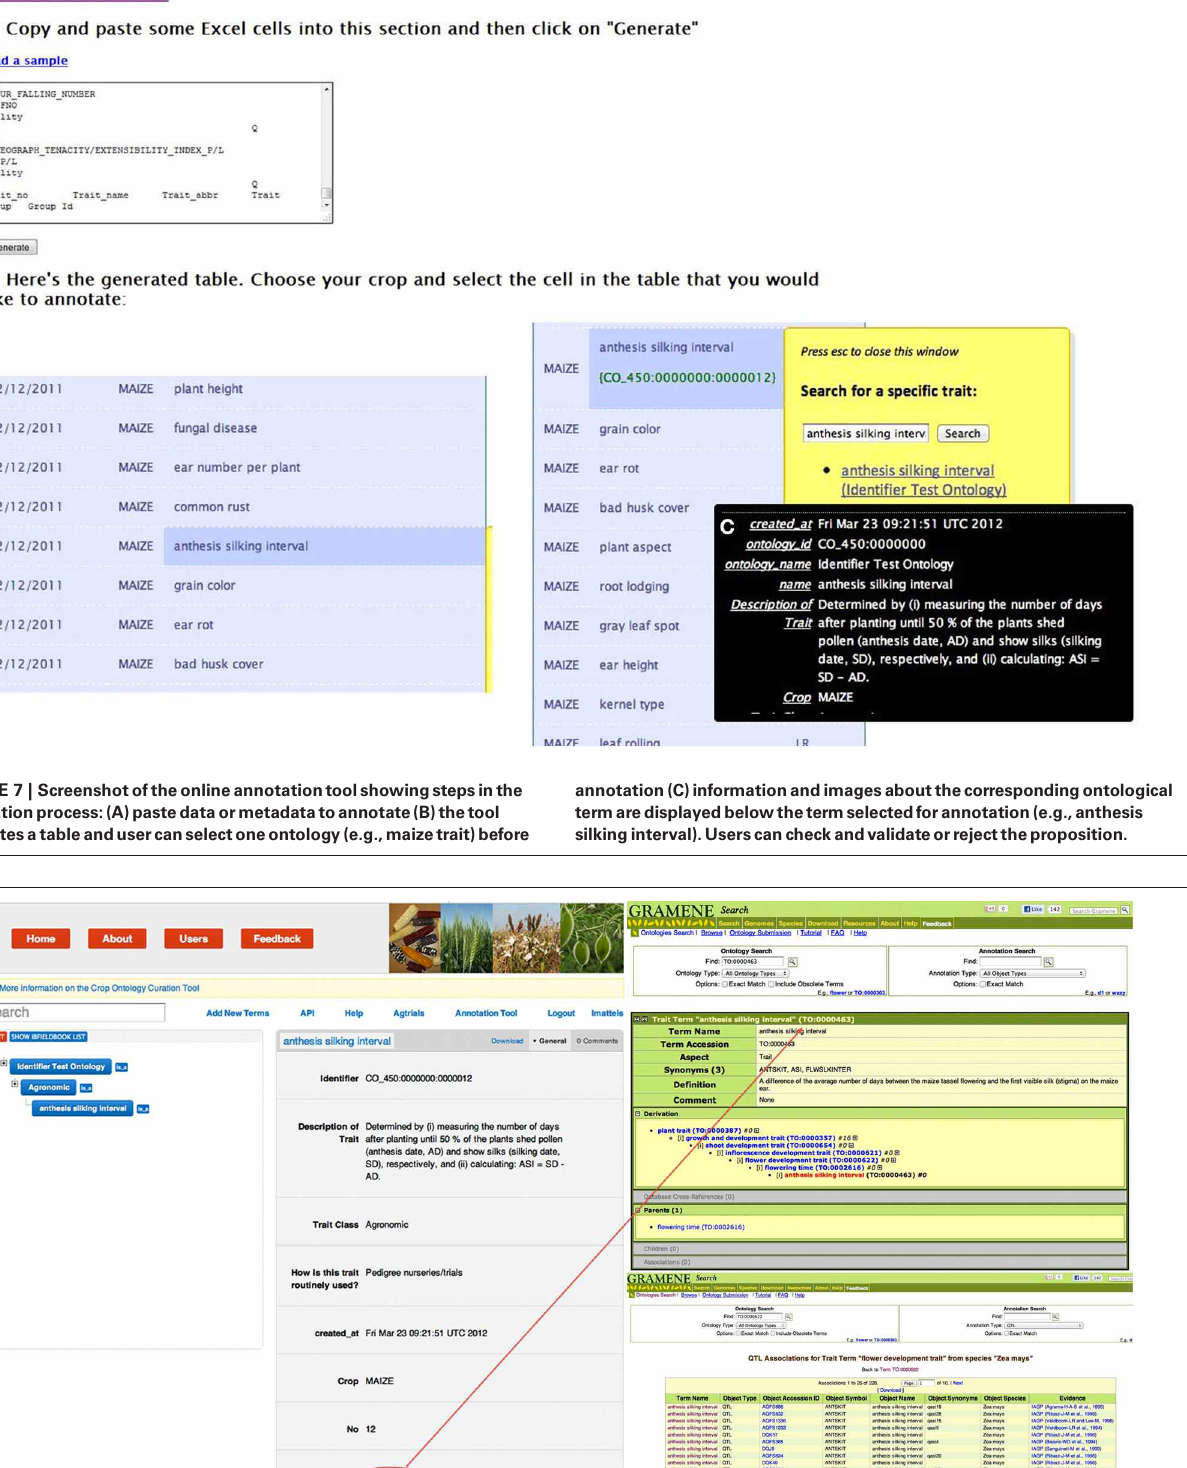
FIGURE 8 | Direct access to the QTL information associated with the trait “anthesis silking interval” on the Gramene website through the cross referencing link placed in the Crop Ontology.